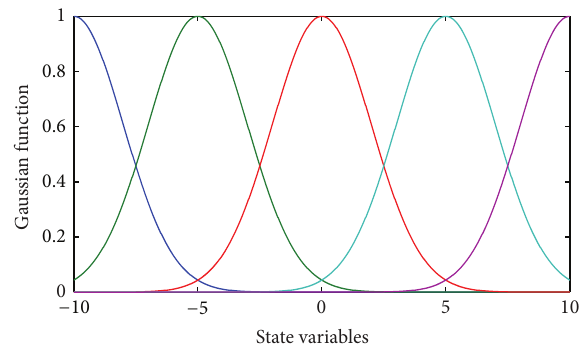
Figure 2: Membership functions in fuzzy